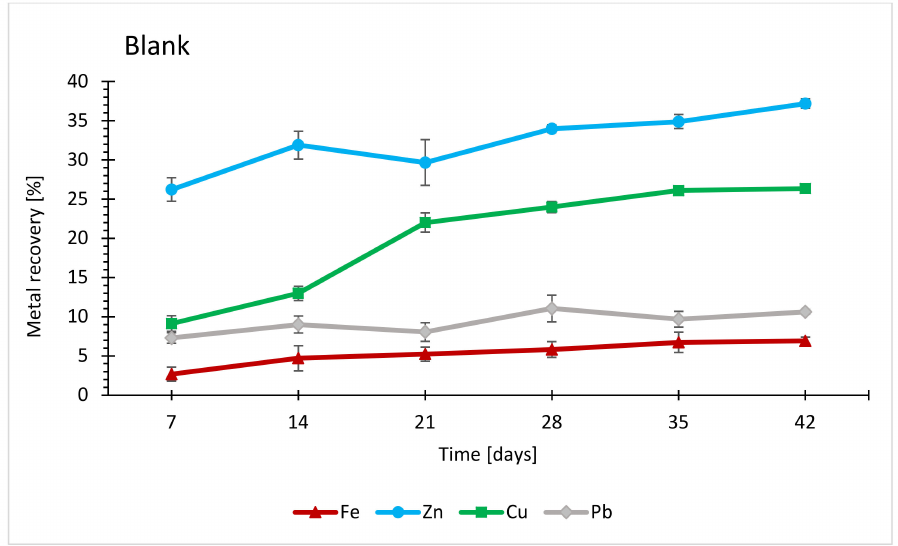
Figure 4. The percentage of metal ions in the extract as a function of time during leaching of H 2 SO 4